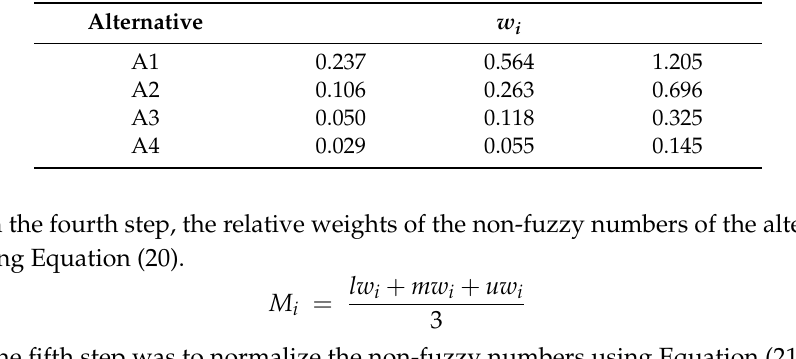
Table 7. Relative fuzzy weights of the alternatives.